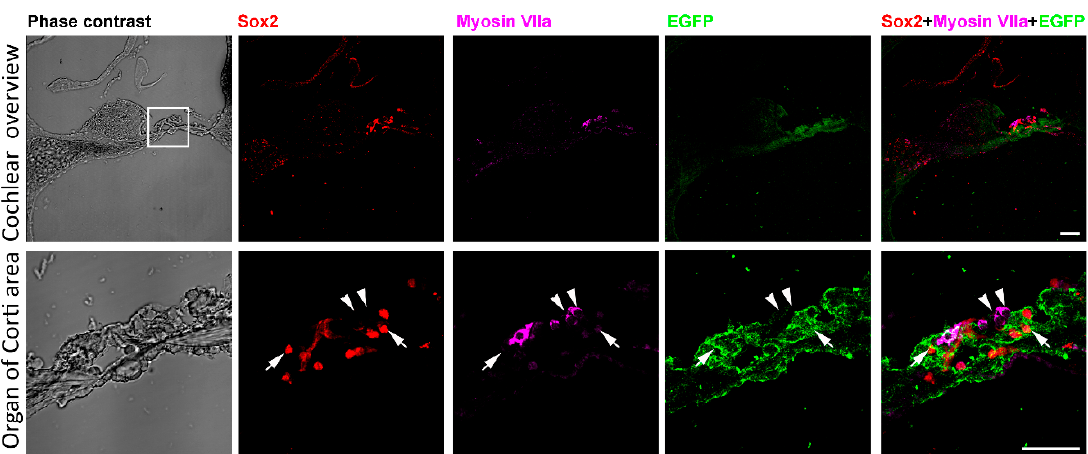
Figure 1. Expression of Sox2 / EGFP in the cochlea. Low magnification phase contrast figures show cochlear section overview, Sox2 immunostaining, Myosin VIIa immunostaining, EGFP expression and the merged image of Sox2, Myosin VIIa and EGFP. The box area indicates the organ of Corti and the high magnification images were shown in the second row. High magnification images demonstrate the organ of Corti area showing the phase contrast overview, Sox2 immunostaining (arrows), Myosin VIIa immunostaining (arrowheads), EGFP expression (arrows) and the merge image of Sox2, Myosin VIIa and EGFP (arrows and arrowheads). It is shown that hair cells are labeled by Myosin VIIa antibodies (arrowheads). Surrounding supporting cells express EGFP and are labeled by Sox2 antibodies (arrows). Scale bar: 50 µm.